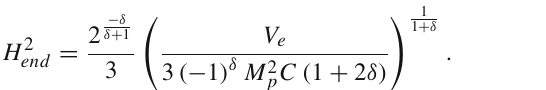
Fig. 2 The non-adiabatic curvature perturbation P ζ different δ values, δ = 3, 4 and 6. The other parameters are given as : √ Φ (cid:4) M / 12 π, g = 10 − 3 , m = 10 − 6 M p , q = p